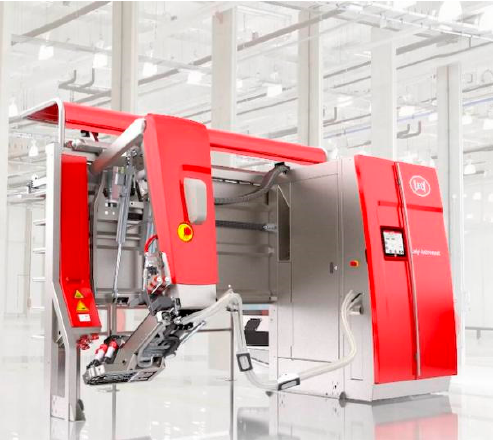
Figure 4. Automatic milking equipment (Source: LELY Industries